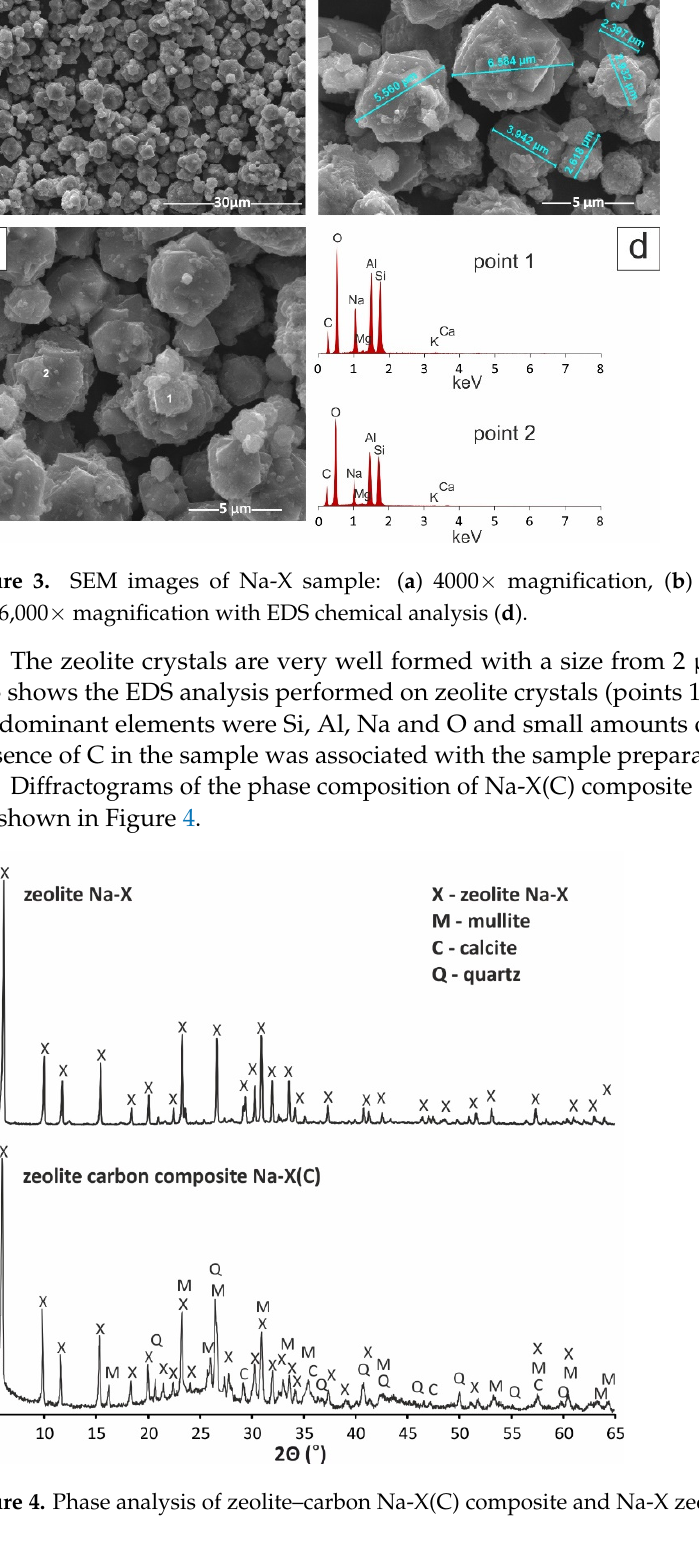
16,000× magnification with EDS chemical analysis ( d ).